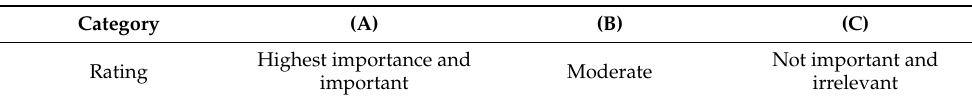
Table 5. Consensus